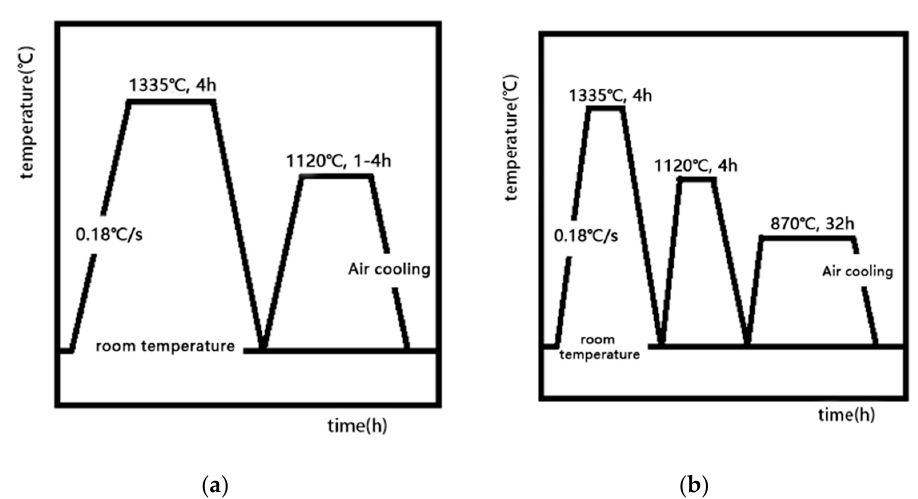
Figure 4. Aging process diagrams ( a ) The aging treatment system: ① – ④ ; ( b ) The aging treatment system: ⑤ . Table 2. Treatment systems.